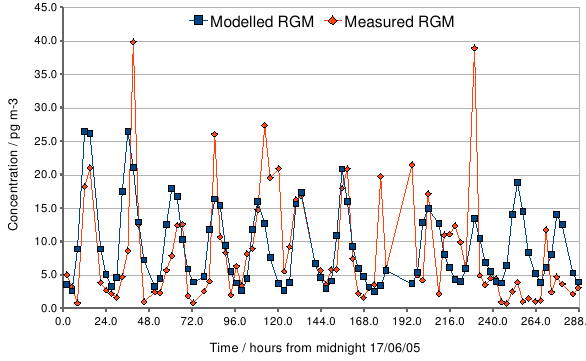
Fig. 7. The measured and modelled RGM concentration, assuming that Hg 0 + O 3 and Hg 0 + OH reaction products do not contribute to RGM and assuming that Hg 0 + Br is the rate limiting step in RGM